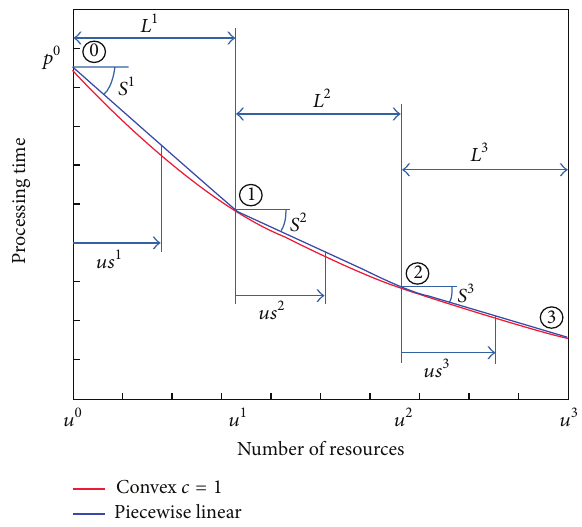
Figure 1: Piecewise linear relationship and convex relationship with 𝑐 = 1 . Subscripts are removed for simplicity in the figure.